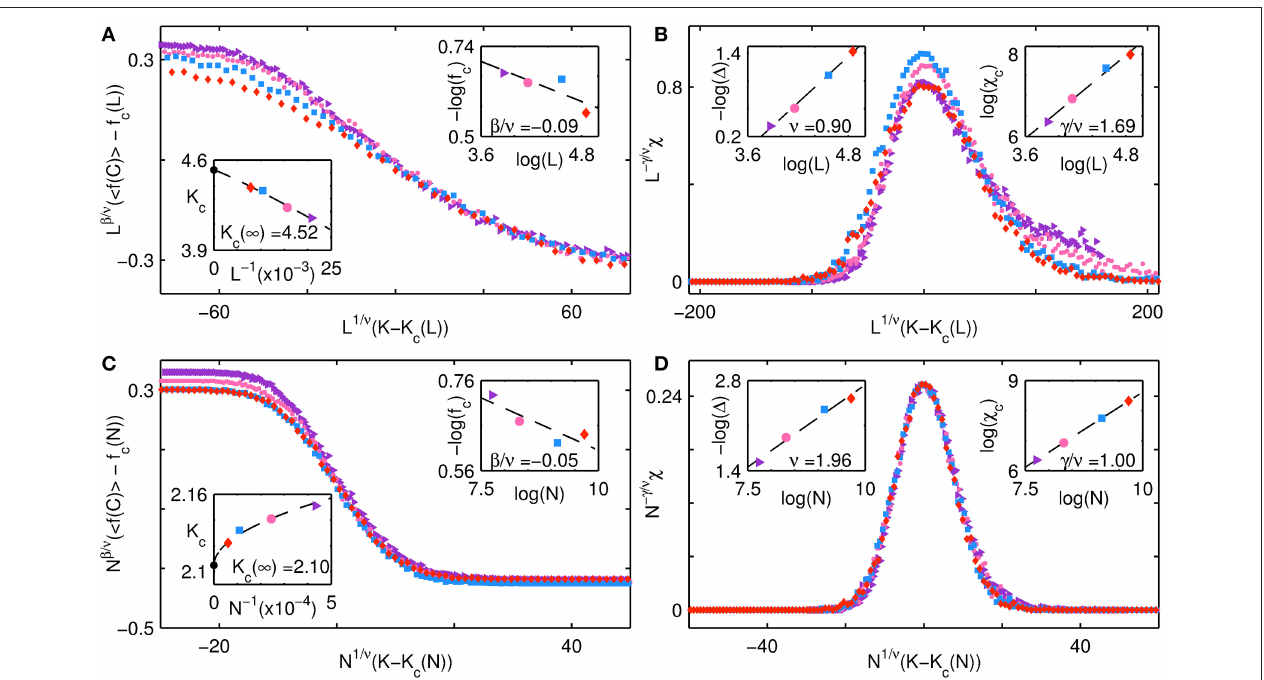
FIGURE 7 | Collective behavior of a network of agents at the interface of the all D and all C regimes for different system sizes. Finite-size scaling results are shown for f ( C ) the cases (A,B) p 0, b 0.94, and (C,D) p 1, b 0.98. (A,C) Show the order parameter, viz., mean fraction of cooperators (averaged over 10 3 trials), = = = = h i while (B,D) show the corresponding dependence of the susceptibility χ (obtained from Equation (2) using values of f ( C ) obtained over 10 3 trials) on K . The abscissae of each of the panels represents the deviation of the noise K from the critical noise value K c ( N ), scaled by N 1 /ν . The ordinate for (A,C) shows the deviation of the order parameter from its value f c ( N ) at the critical point K c ( N ), scaled by N β/ν , while the ordinate for (B,D) shows the susceptibility scaled by N γ/ν . The curves are seen to collapse upon using exponent values obtained from finite-size scaling, viz., (A,B) ν 0.90 0.04, β/ν 0.09 0.04, γ/ν 1.69 0.12 and (C,D) = ± = − ± = ± ν 1.96 0.20, β/ν 0.05 0.02, γ/ν 1.00 10 − 4 . The insets in (A,C) show the least-square fits of Equation (3) to K c and log ( f c ) to log ( N ), while the insets in = ± = − ± = ± (B,D) show the least-square fits of log ( 1 c ) to log ( N ) and log ( χ c ) to log ( N ). Different symbols are used to indicate the different system sizes N for which the simulations were carried out, namely, a purple triangle ( N 48 2 ), a pink circle ( N 64 2 ), a blue square ( N 96 2 ) and a red diamond ( N 128 2 ). Note that for the case p 0, = = = = = i.e., (A,B) , the scaling is in terms of L rather than N